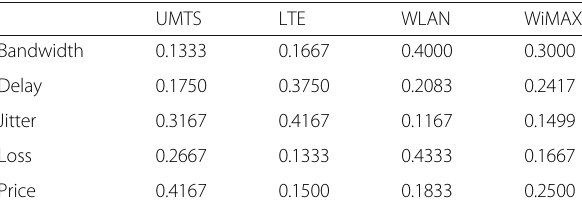
Table 16 Network attributes and candidate networks relationship matrix UMTS LTE WLAN